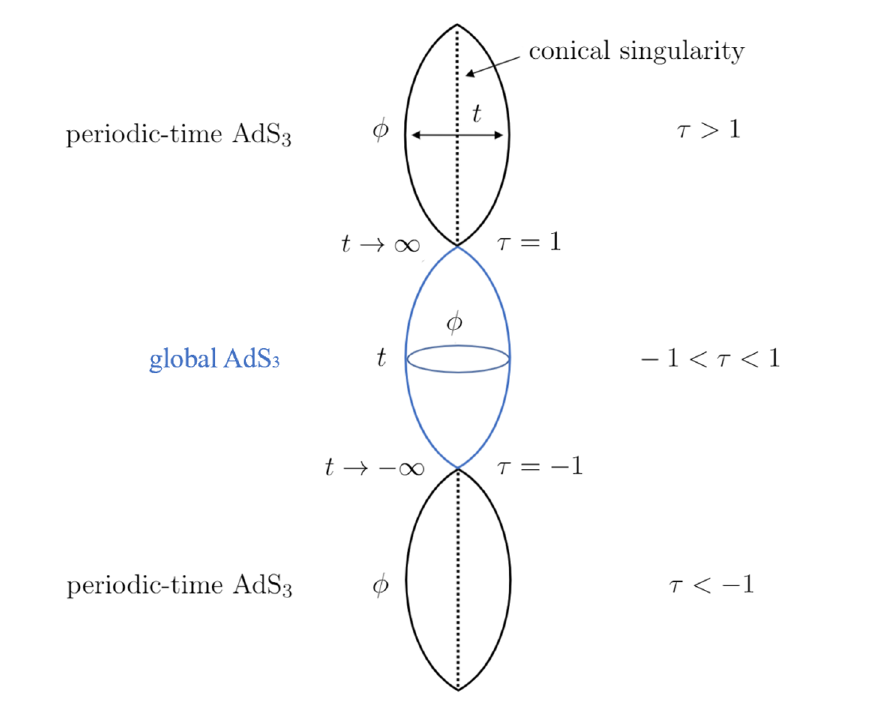
Figure 4. Sketch of the bulk for α > 1 / 2 states (not a proper Penrose diagram). The boundary is a single, complete Misner-AdS 2 geometry with chronology horizons at τ = ± 1 , but the bulk consists of three disconnected spacetimes. For − 1 < τ < 1 , it is a geodesically complete, global AdS 3 spacetime, with time coordinate t ∈ ( −∞ , + ∞ ) and without CTCs. For | τ | > 1 , the bulk is an AdS 3 geometry, with CTCs since the time φ is periodically identified (not represented in the figure), and with a conical singularity at the origin r = 0 , since the ‘angular’ coordinate t runs in ( −∞ , + ∞ )